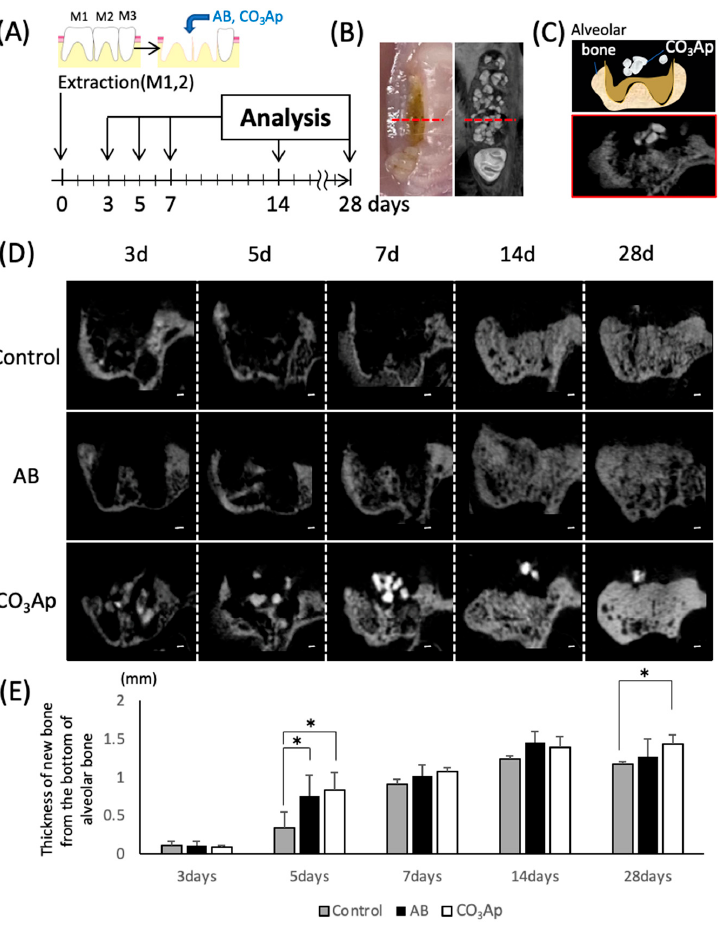
Figure 2. Evaluation of the chronological bone formation with micro-CT. ( A ) Schematic of the tooth extraction model. The right maxillary first (M1) and second molars (M2) were replaced by bone substitute. Experimental protocol of the in vitro study as described in the Materials and Methods section. ( B ) Landmark of the micro-CT image. The anteroposterior position at that time was located by the central part of the second molar (maximum crown diameter) on the opposite side. ( C ) Image of the frontal section at the observation site (schematic and CT image). ( D ) Evaluation of chronological changes in the extraction socket using micro-CT (control: extraction socket, AB: with autogenous bone, CO 3 Ap: with Cytrans). Bars = 200 μ m. ( E ) Thickness of the new bone from the bottom of the alveolar bone ( n = 5, * p < 0.05).